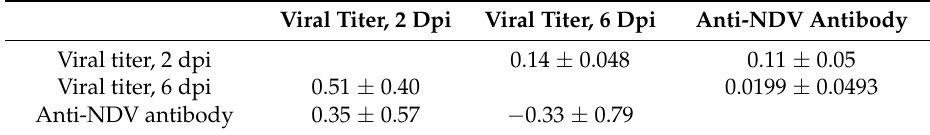
Table 2. Estimates of phenotypic (above diagonal) and genetic correlations (below diagonal) of NDV related traits.